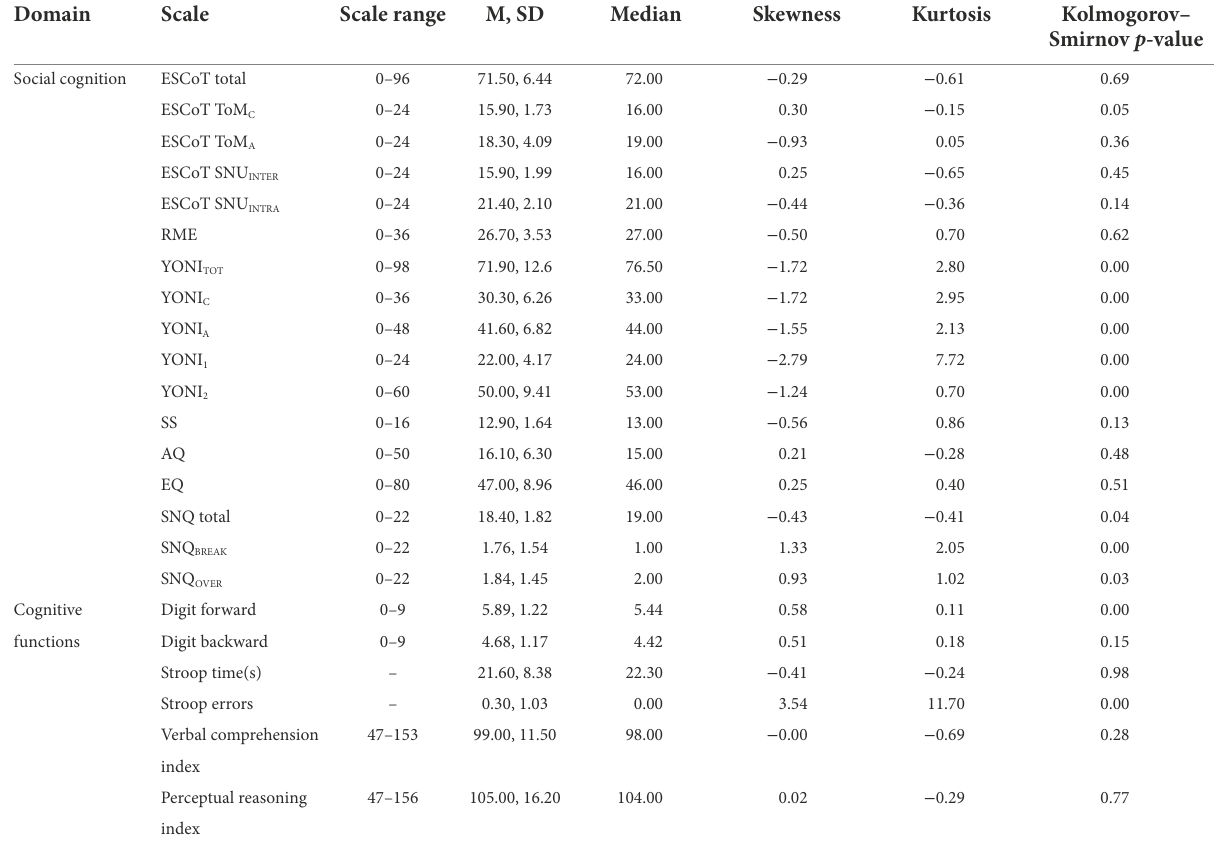
TABLE 1 Participants’ performance on social cognition and neuropsychological tests.